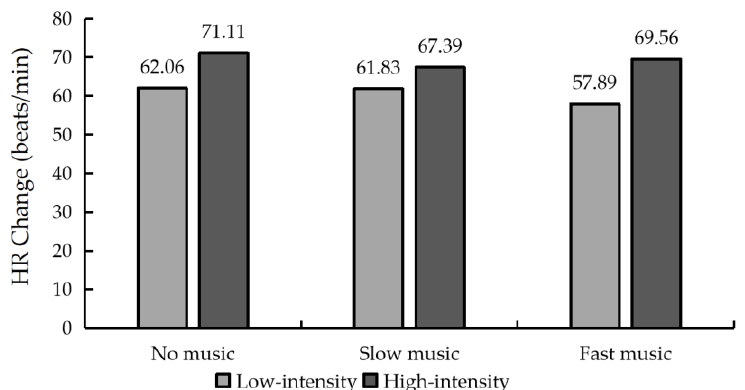
Figure 5. Differences in HR before and after running under different experimental conditions.